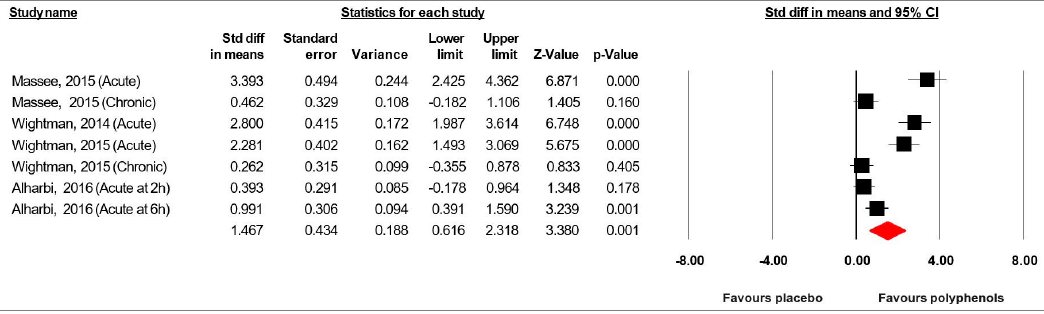
Figure 8. Forest plot of studies investigating the effect of (poly) phenol-rich supplementation on Serial Sevens subtraction task (correct in number) (SS-7s).